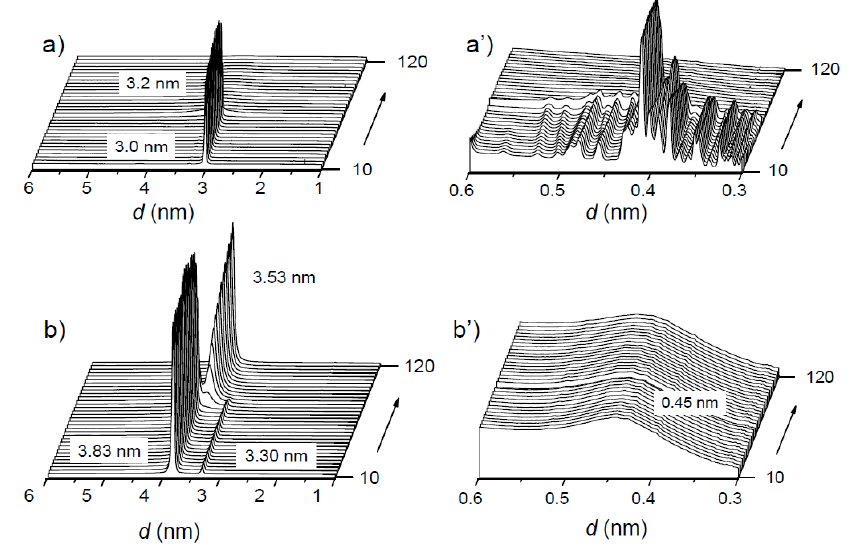
Figure 6. Evolution of the SAXS and WAXS profiles of LAE ( a , a’ ) and LAE · PGGA-1 ( b , b’ ) at heating from 10 to 120 °C.